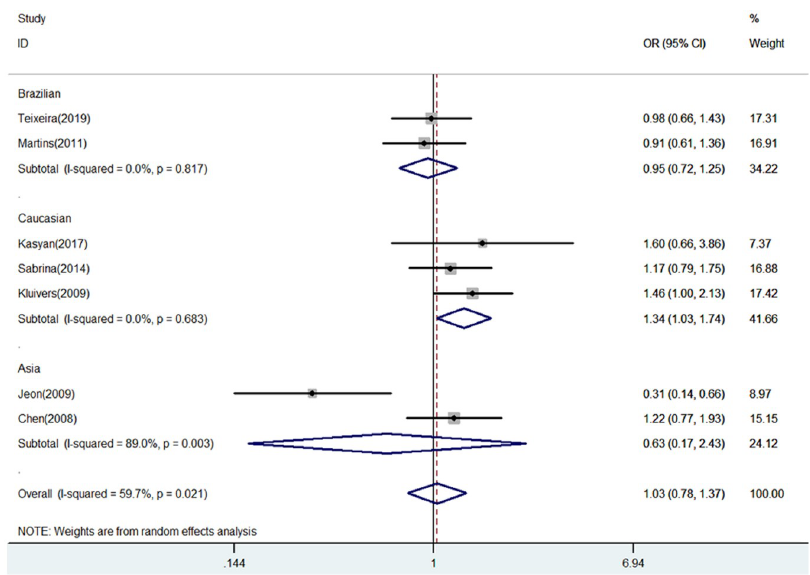
Fig 1. Forest plot of COL3A1 rs1800255 polymorphism on POP risk (allele contrast A vs. G). POP, pelvic organ prolapse; OR, odds ratio; CI, confidence interval.